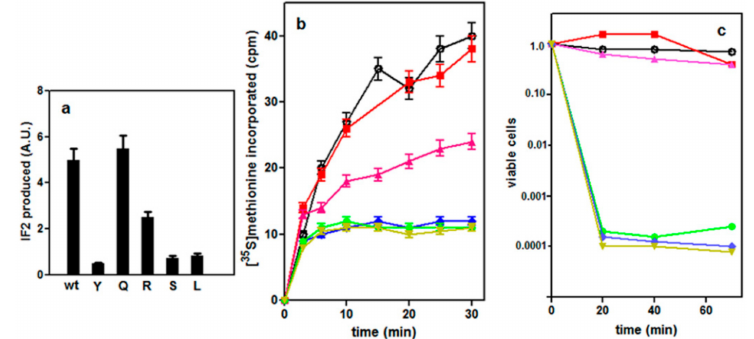
Figure 2. Dominant lethal phenotype caused by overproduction of IF2H301 substitution mutants. ( a ) Amounts of wtIF2 and IF2His301 mutants (as indicated in the abscissa) detected in E. coli cells 30 min after induction of their expression; ( b ) in vivo [ 35 S] methionine incorporation in acid insoluble material as a function of the times (indicated in the abscissa) after induction of expression of the IF2 variants; ( c ) viable E. coli cells counted after induction of the IF2 variants. The symbols in panels (b) and (c) correspond to: wtIF2